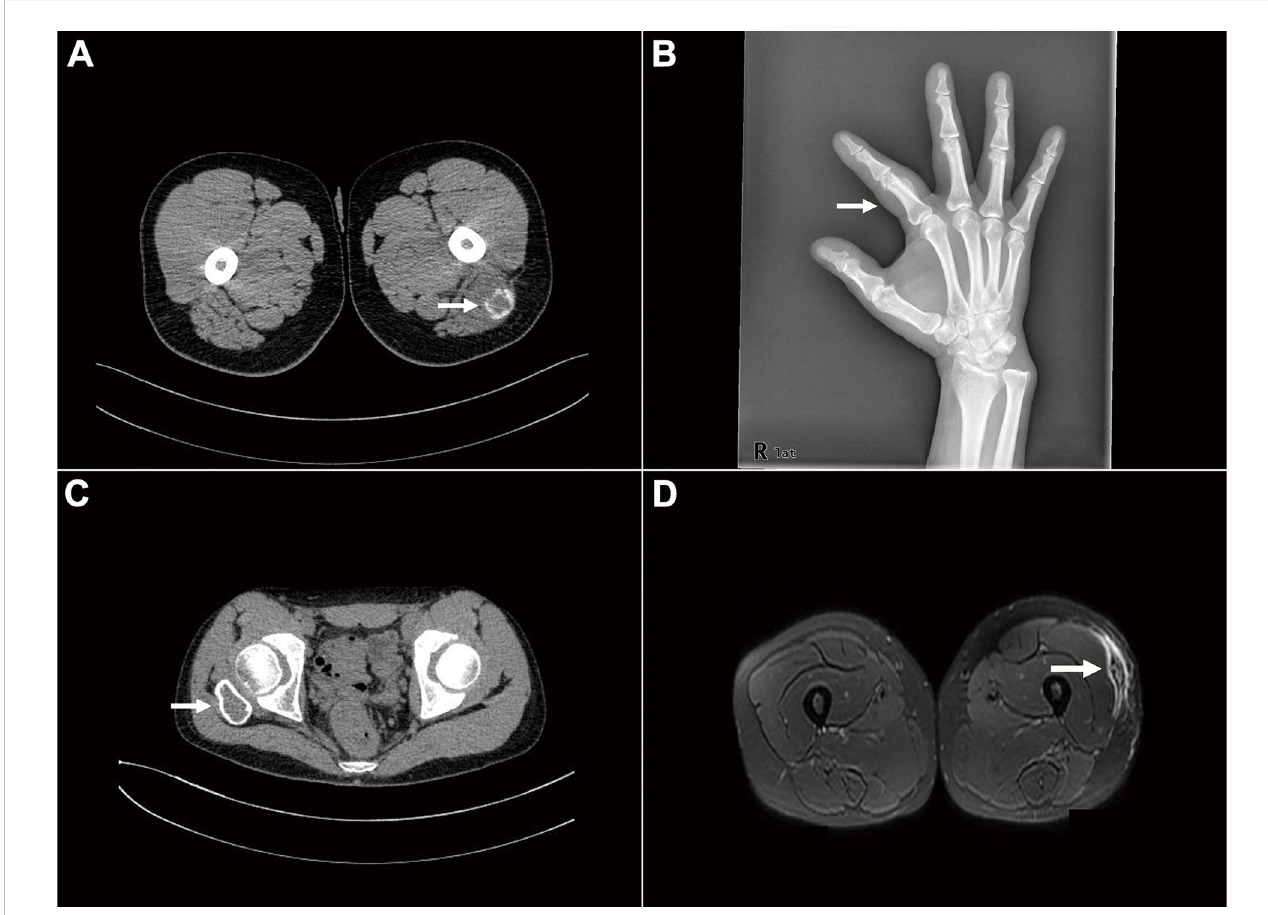
FIGURE 1 Imaging fi ndings of USP6 -associated soft tissue tumors with osteoid tissue. (A) CT showed a soft tissue density mass in the muscle, with well-de fi ned boundaries and circumferentially circular density (arrow) (Case 33). (B) X-rays demonstrated a soft tissue mass in the right fi nger with calci fi cation (arrow) (Case 54). (C) CT showed mixed-density shadows with clear boundaries around the right hip (arrow) (Case 60). (D) MRI showed mixed signals in the subcutaneous fat layer of the left thigh, with clear boundaries (arrow) (Case